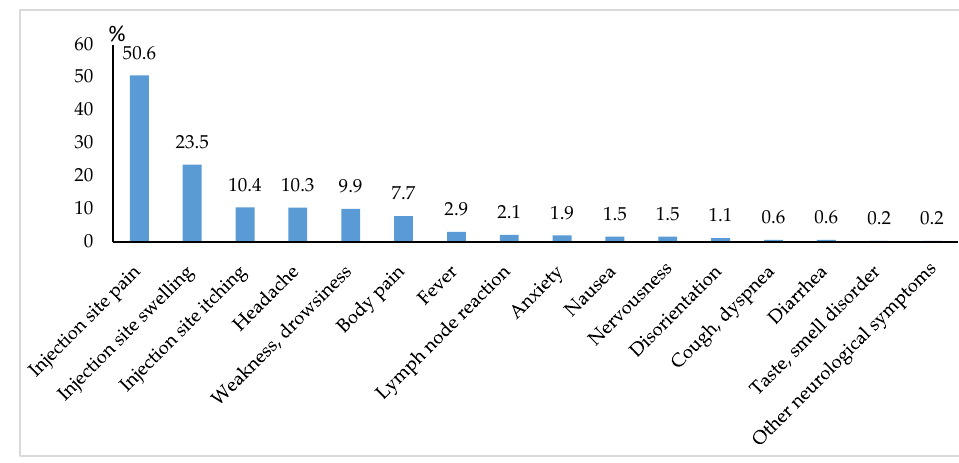
Figure 1. Frequency of adverse events by symptoms.